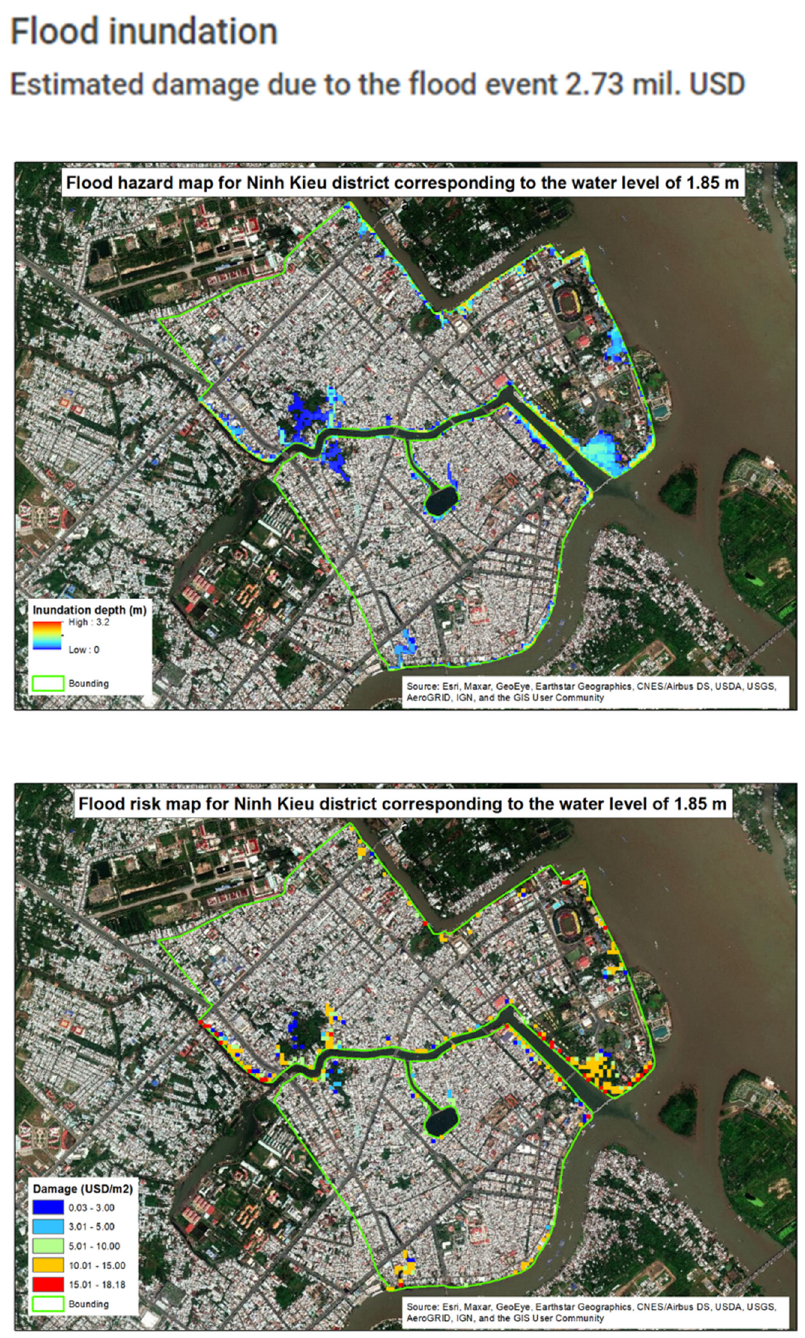
Figure 2. The inundation map, flood damage map, and the estimated total flood damage due to the flood event for the Ninh Kieu district, Can Tho city.